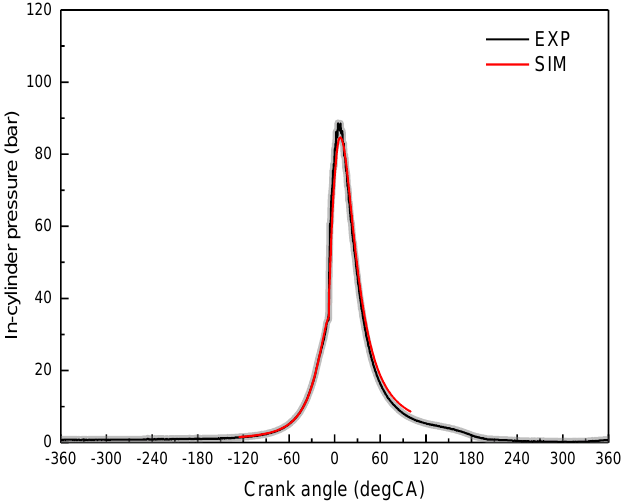
Figure 7. Comparison of numerical and experimental pressure with an error bar of 2% at an altitude of 3 km.